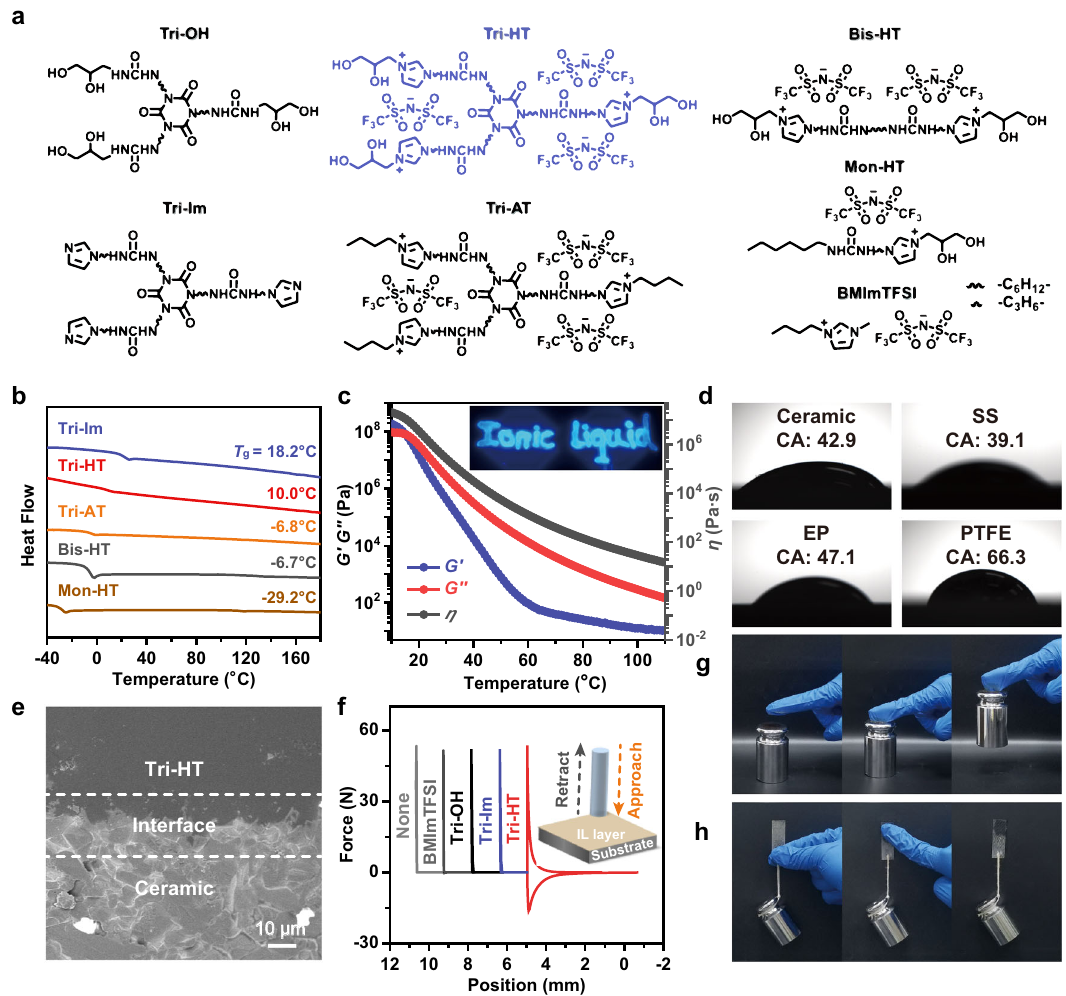
Fig. 1 | Structures and properties of the Tri-HT and reference compounds. a Chemicalstructuresand b DSCcurves. c Temperature-dependentrheologicaltest of Tri-HT (angular frequency=10rads − 1 , strain=1%). Inset shows the room- temperaturephotograph of Tri-HTonPTFE under ultraviolet light irradiation after being extruded from a syringe at a high temperature. d Contact angles of molten